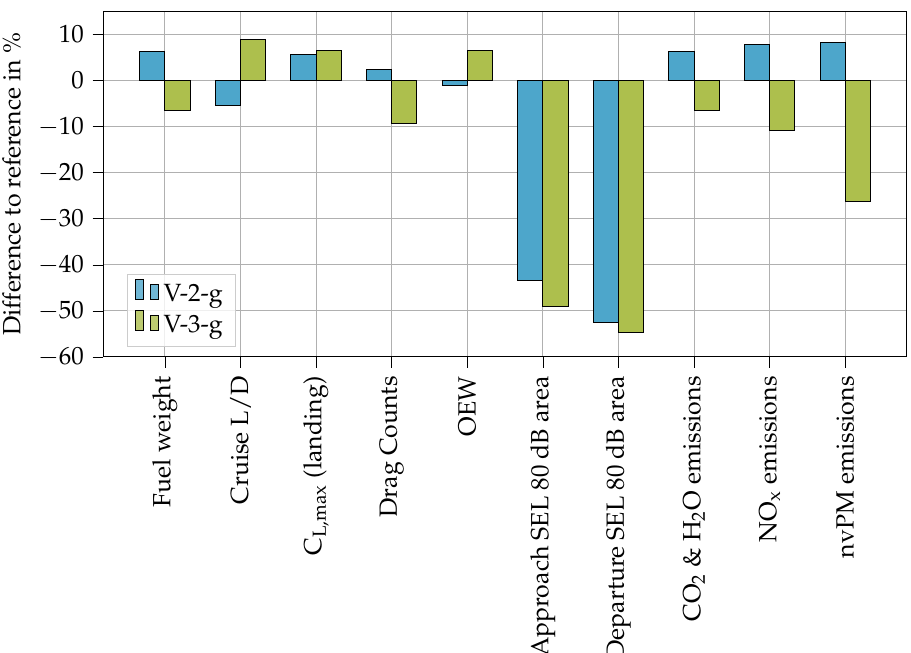
Figure 16. Difference of V-2-g and V-3-g to the reference design V-R-g ( neo